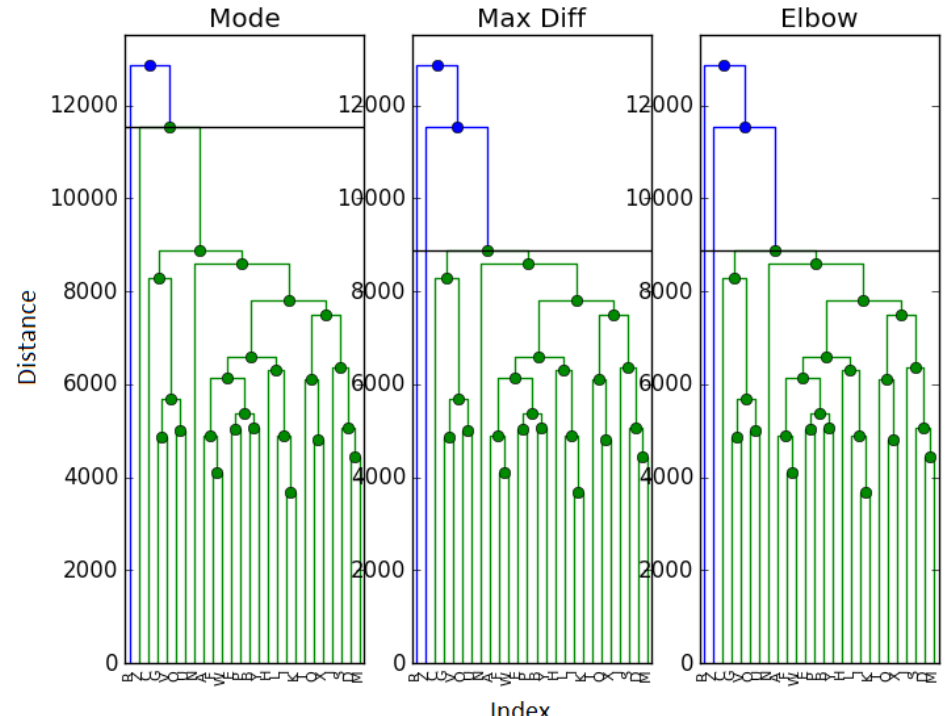
Figure 7. Clustering of the ExpressionSet with